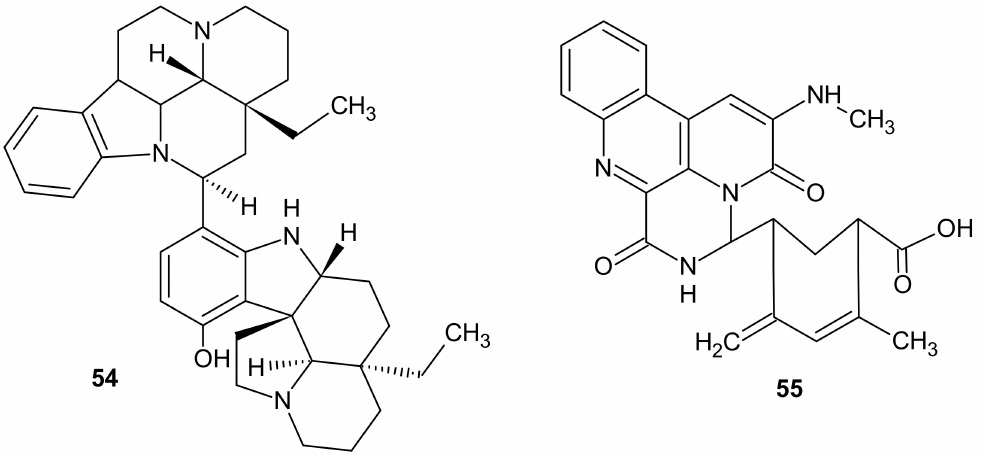
Figure 16. Bisleuconothine A 54 and 1- N -methyl-3-methylamino-[ N -butanoicacid-3-(9-methyl-8-propen-7-one)-amide]- benzo[ f ][1,7]naphthyridine-2-one 55 .